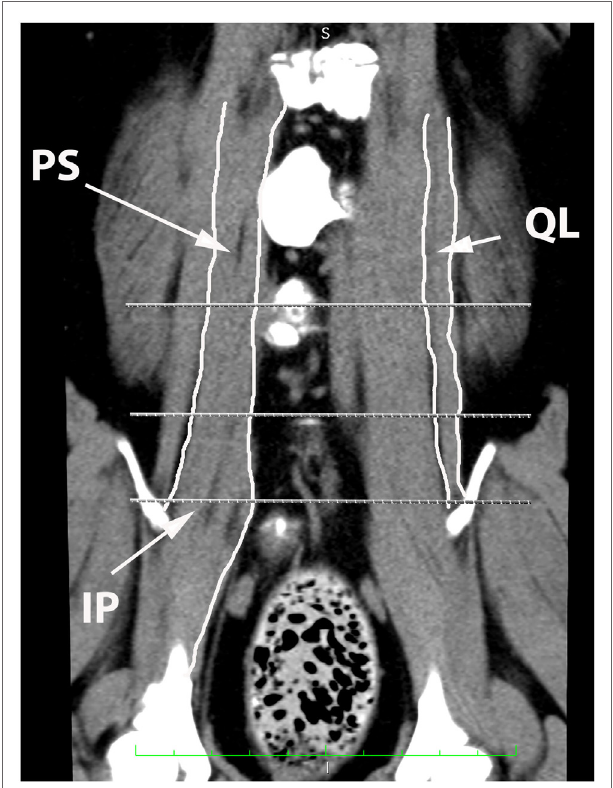
FIGURe 10 | dorsal oblique multi-planar Ct image at the level of the ventral vertebral bodies, illustrating margins of the quadratus lumborum (QL), psoas (Ps), and iliopsoas (IP) muscles .